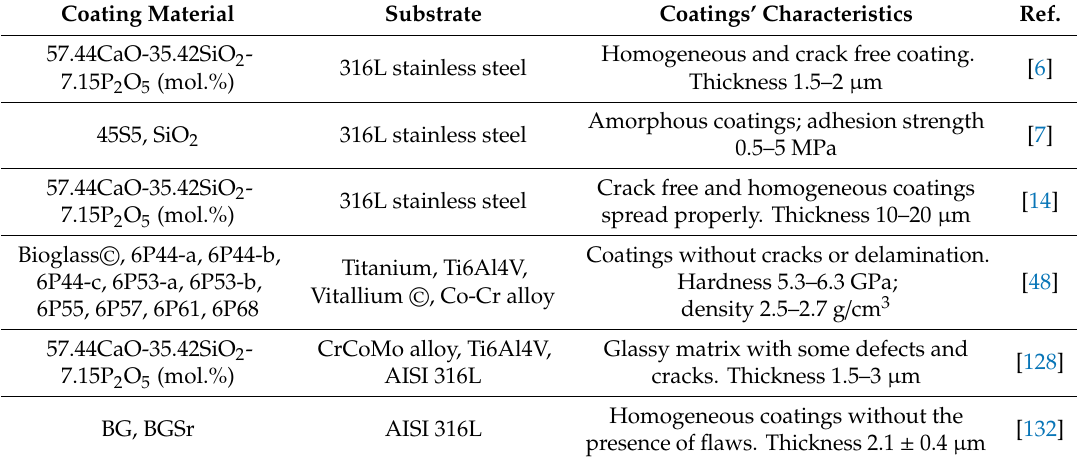
Table 3. Summary of bioactive glass coatings obtained by sol-gel